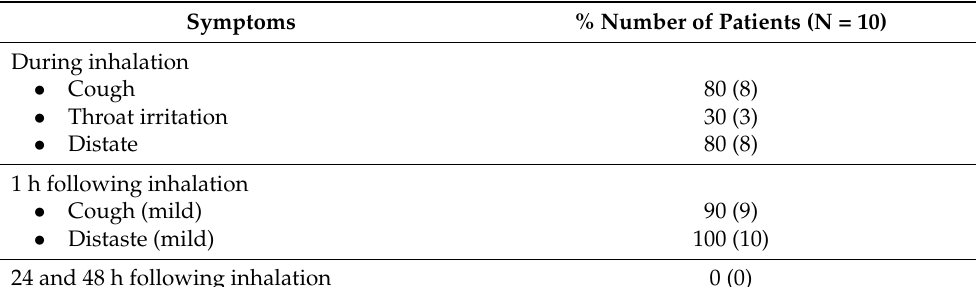
Table 6. Adverse effects following pulmonary dosing with TAC-LAC dry powder for inhalation (3 mg